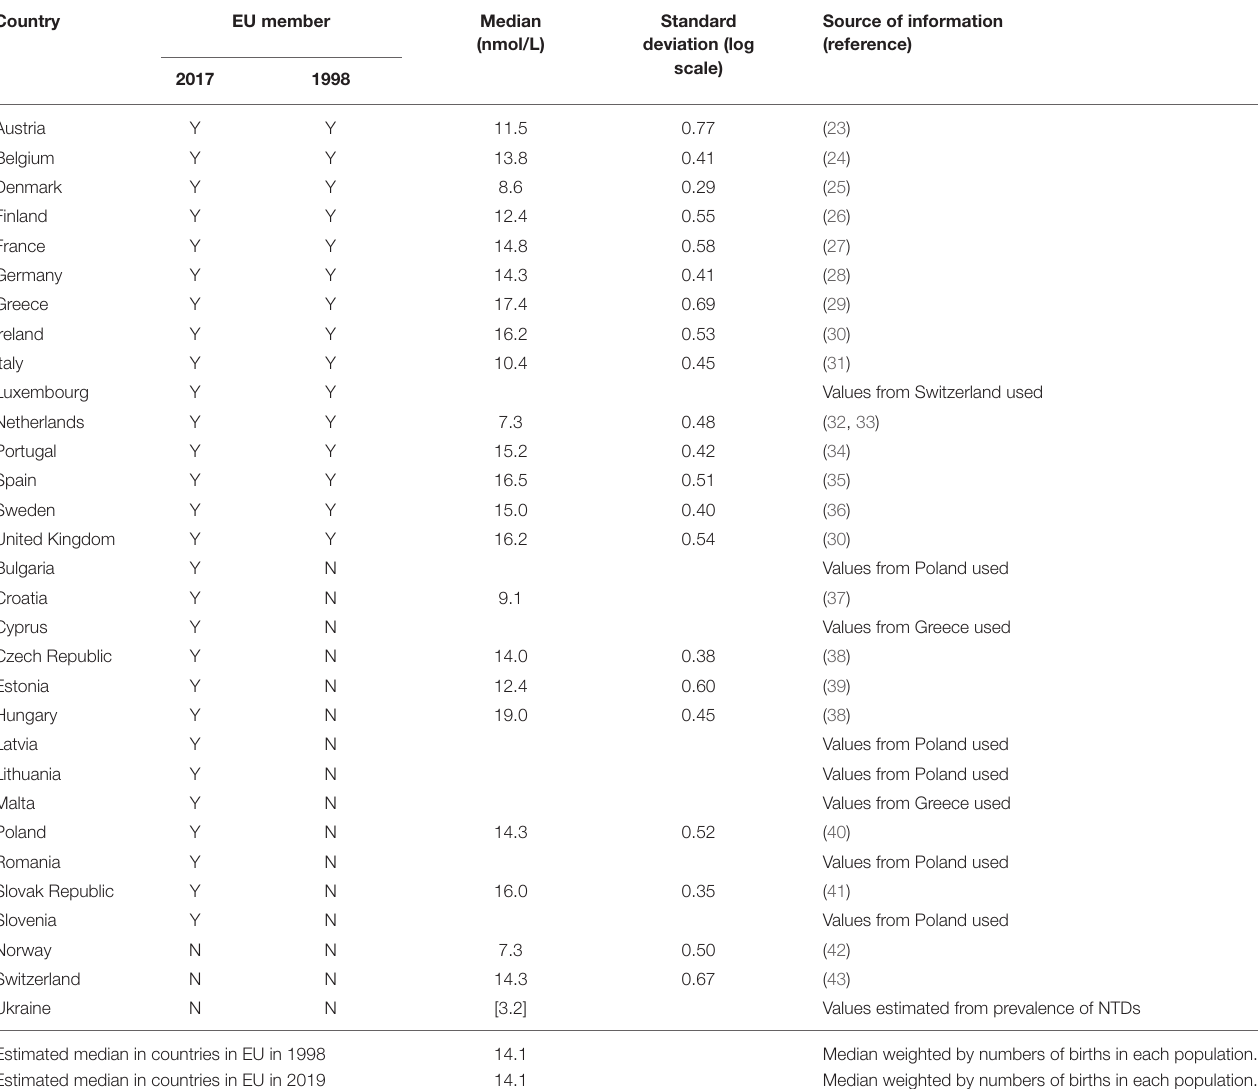
TABLE 2 | Estimated median folate levels and standard deviations (on a log scale) in European countries.